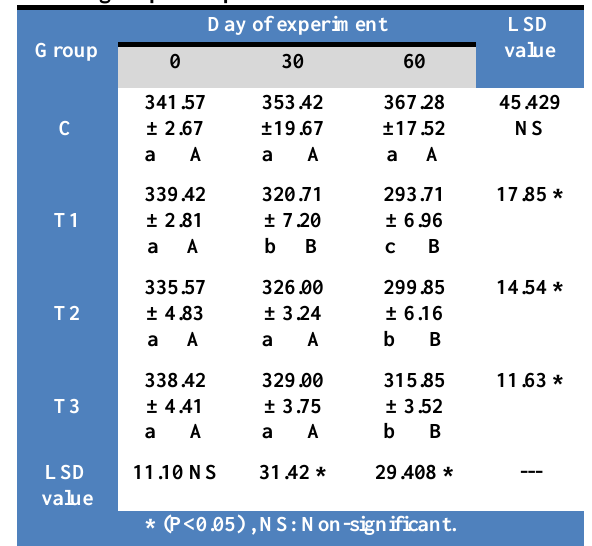
Table, 7: Show the development of body weight of adult male rats during the experiment period in all treated groups compared with